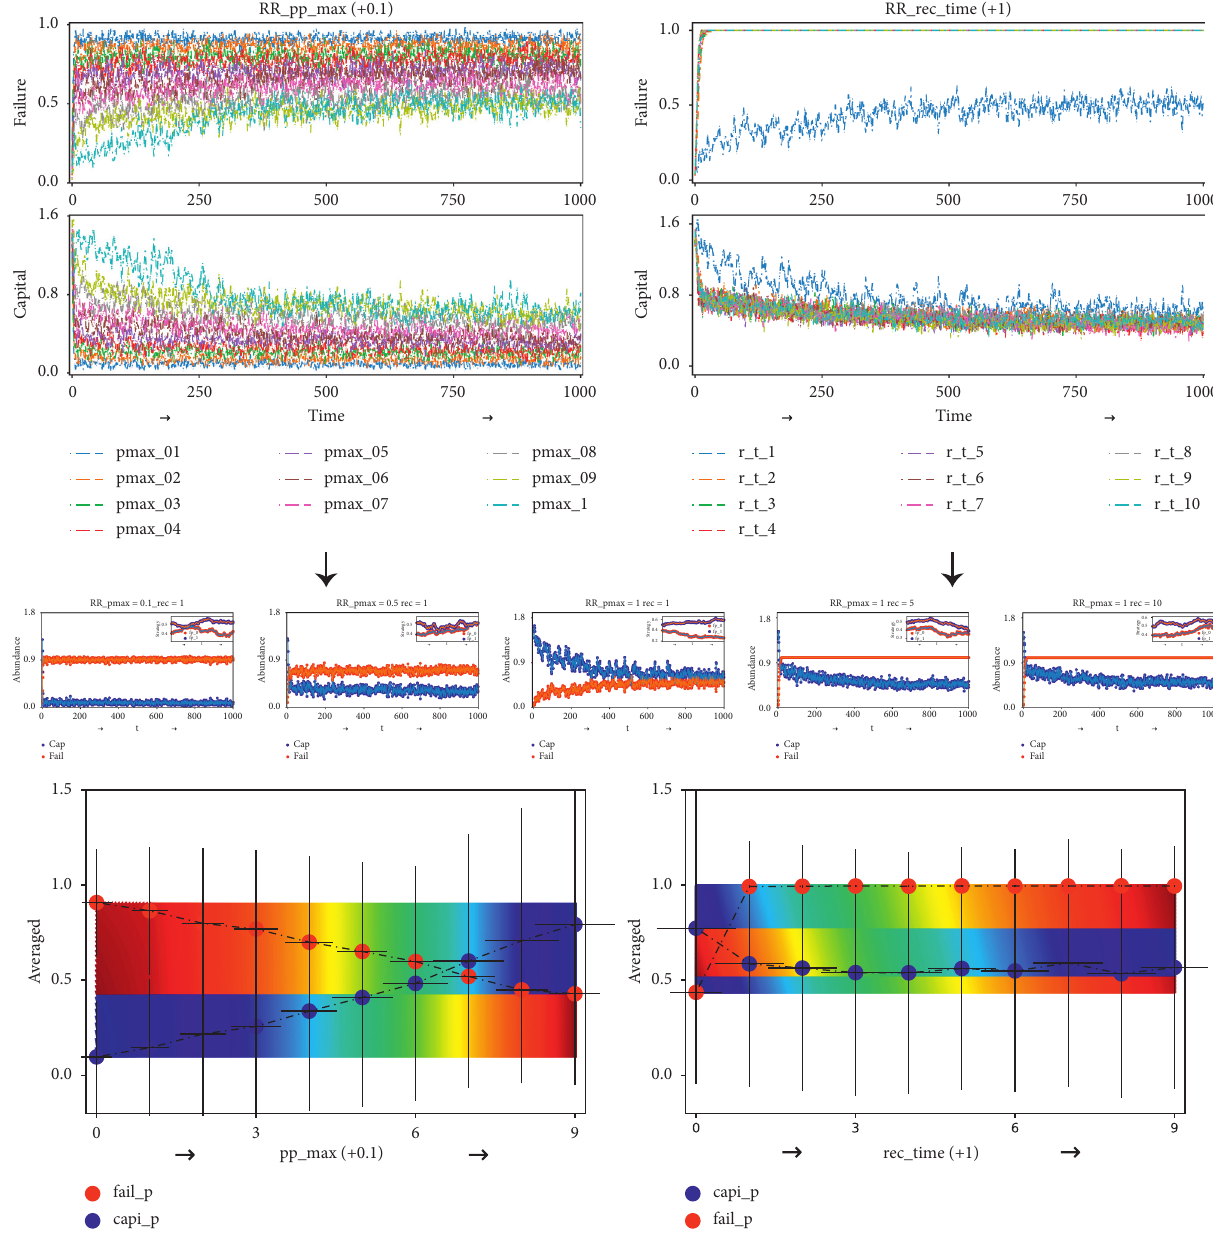
Figure 20: Stationarity in time series with the random regular graph (nodes � 10 ∗ 10, connection d � 9, time steps � 1,000). The set on the left-hand side shows the results controlled by the protection maximum, and the set on the right-hand side shows the results with a recovery time delay (dots � averaged values; dashed lines � variation). The upper plot shows the failure and capital combined (vertical axis � value corresponding to the time step [horizontal axis]). The plot in the middle shows failure (red) and capital (blue) (vertical axis � value corresponding to the time step [horizontal axis]). The inset plot shows the trend of the two strategies ( f p pendixes 4 and 5 for the results of the entire simulation). The lower plot shows the averaged outcomes (vertical axis) for capital (blues) and failure (reds), according to the recovery time delay (rec_time[+1]) and protection maximum [pp_max(+0.1)] (see legend). The background contour shows the dominance between the outcomes, and all the dashed lines denote the